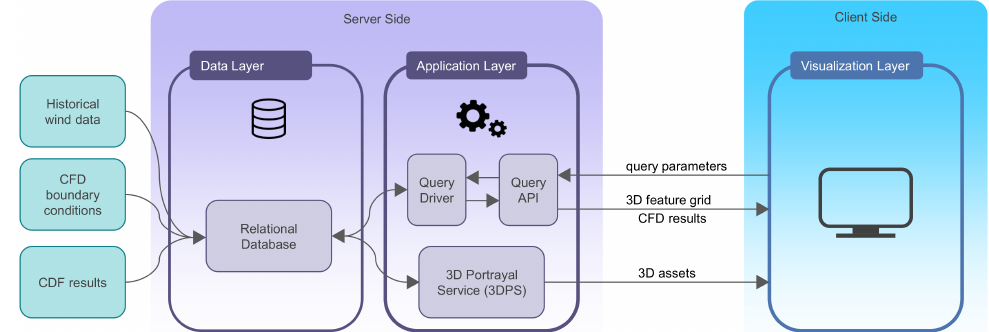
Figure 6. From left to right : The data tier, application tier, and web tier of the full-stack application.